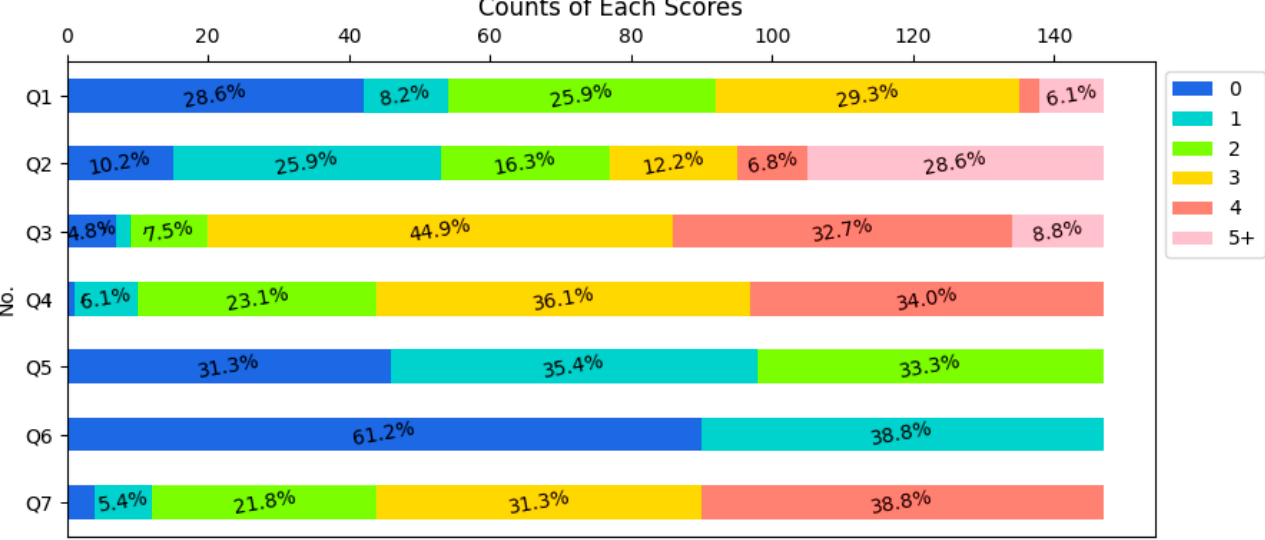
Figure 6. Statistics of each score count. The x-axis is the sum of the total numbers of check-in marks (total 147), and the y-axis lists the question numbers (from Q1 to Q7). The bars present the percentage of answers (from 0 to 5+). Since the maximum for each answer is not the same, this bar chart shows the statistics in percentages.